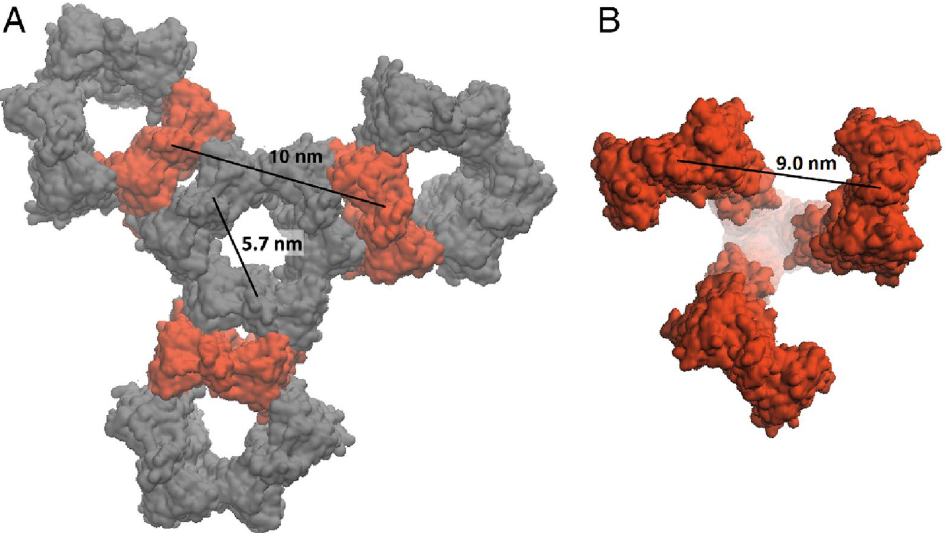
Figure 5. Inter-dimer distances between transmembrane parts of the Np SRII/ Np HtrII dimers. ( A ) Characteristic distances between dimers in 2D-array proposed in 31 . ( B ) The "tripod"-shaped model of the trimer of dimers (Fig. 4B) demonstrating the inter-dimer distance of 9.0